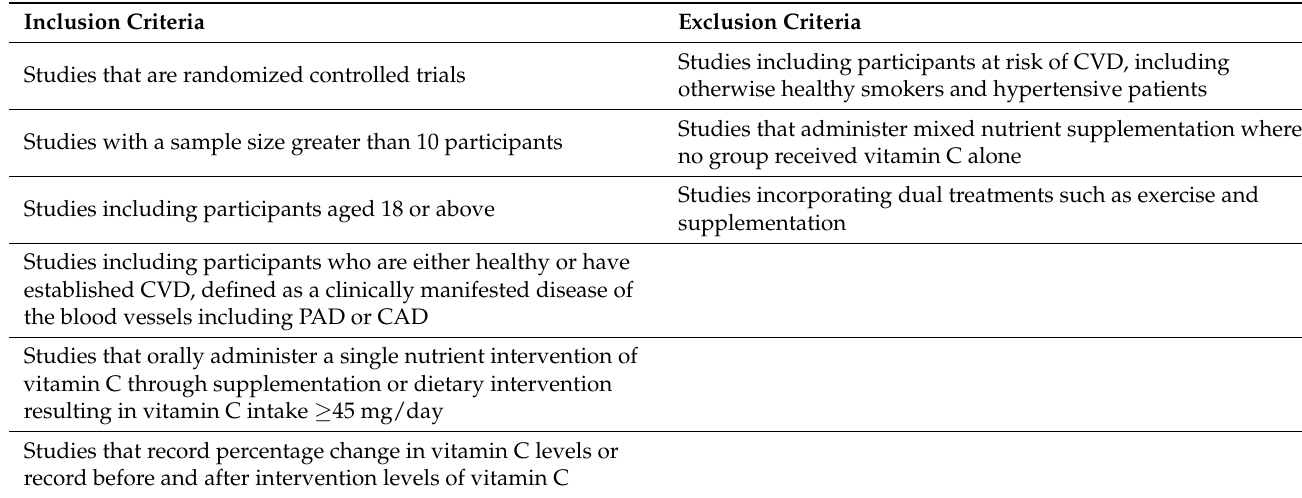
Table 2. Inclusion and Exclusion